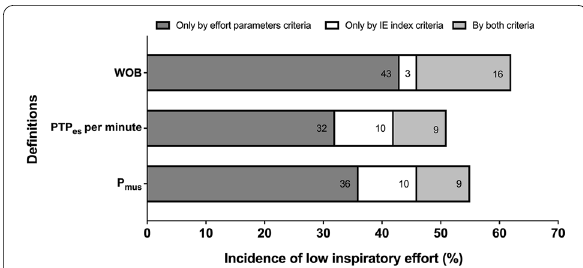
Fig. 3 Incidence of low inspiratory effort by different definitions. Data are shown as low inspiratory effort only defined by criteria of work of breathing (WOB), esophageal pressure–time product (PTP es ) per minute, or inspiratory muscle pressure (P mus ), only defined by criteria of ineffective effort (IE) index, and defined by both effort parameters based on esophageal pressure and IE index